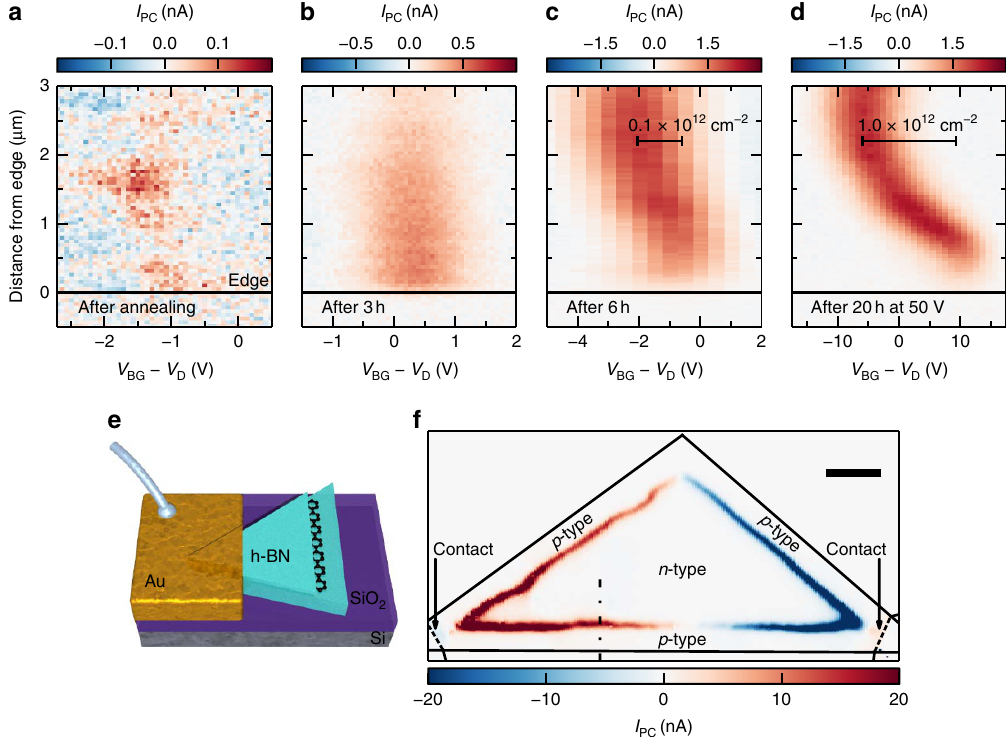
Figure 5 | Near-field photocurrent maps revealing edge doping in encapsulated graphene. ( a ) Spatial photocurrent profile versus backgate voltage V BG (minus voltage of the resistance maximum V D ) near the edge of encapsulated graphene. These data are taken directly after annealing the device. ( V D ¼ (cid:2) 0.3V). ( b ) The same scan on the same device after three hours in air, ( V D ¼ (cid:2) 0.5V) and c , after annealing and applying V BG up to 3V ( V D ¼ 3V). ( d ) The same scan after approximately 20h in air and after applying V BG up to 50V ( V D ¼ 30V). ( e ) Sketch of the device, a stack of h-BN(46nm)/ Graphene/h-BN(7nm) on a Si/SiO 2 (300nm) wafer used as global backgate. In this sketch we only show one of the two contacts used for electrical measurements. ( f ) Photocurrent close to the resistance maximum at V BG ¼ (cid:2) 28V shows a triangular photocurrent pattern, due to edge p-doping. The dashed dotted line indicates where the measurements in a – d were taken. (scale bar, 2 m